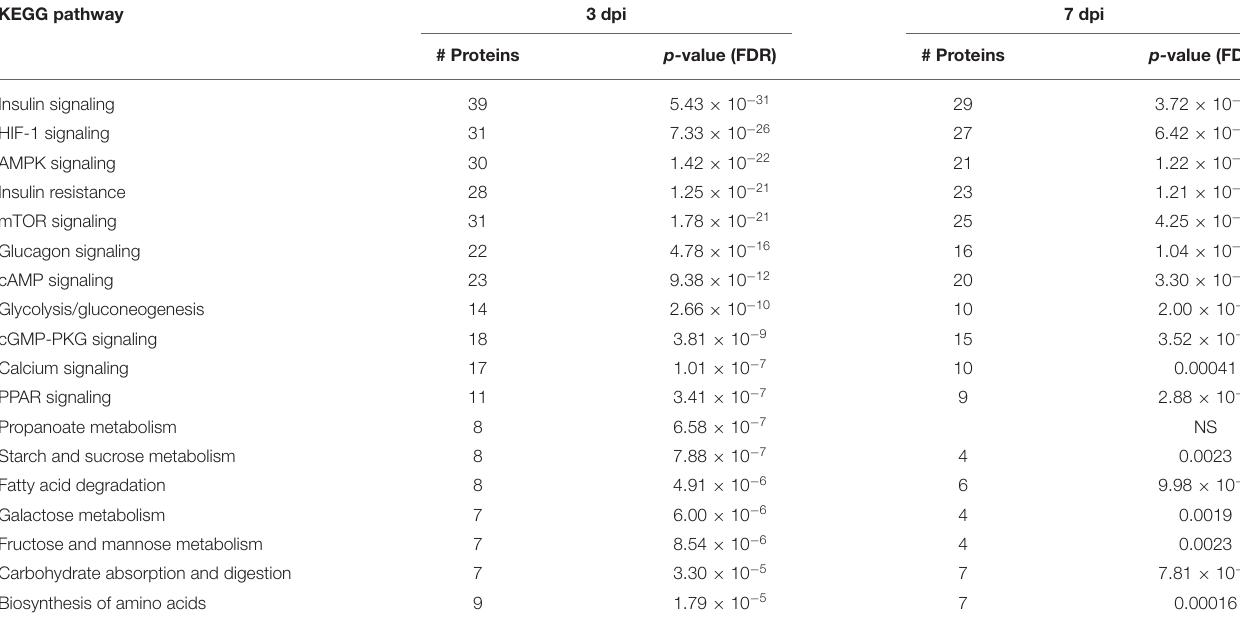
TABLE 3 | KEGG metabolic pathways enriched from unique peptides in SPORE (compared to CON) birds 3 and 7 days post-inoculation. KEGG pathway 3 dpi